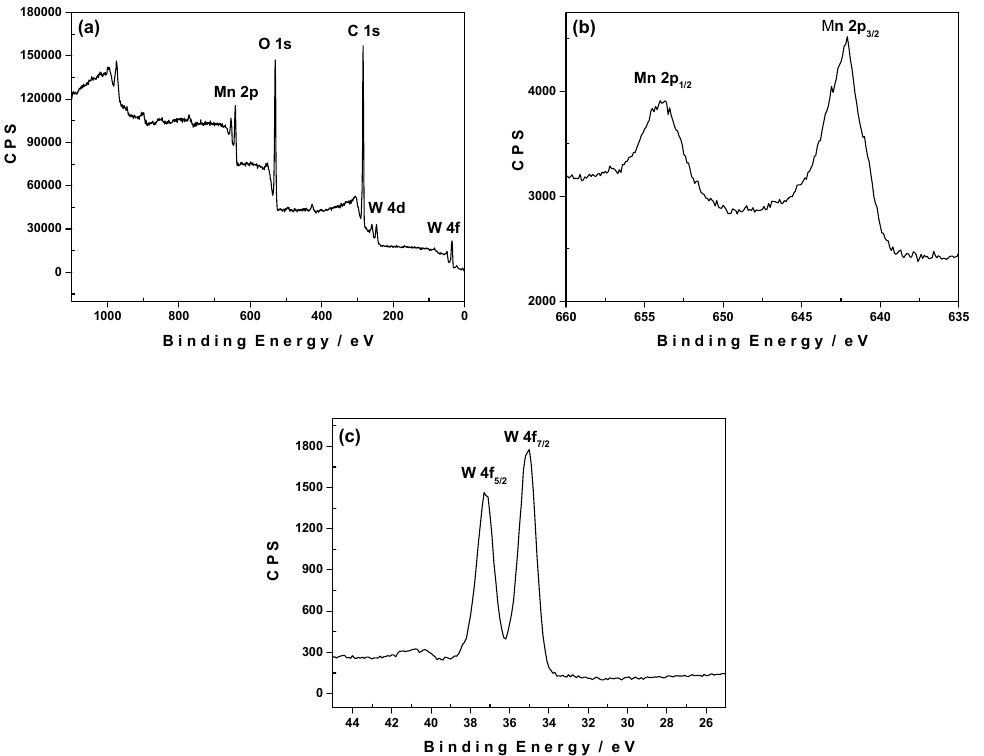
Figure 10. ( a ) XPS survey spectrum for a 1 -modified glassy carbon electrode by induced electrochemical deposition at +1.4 V vs. SCE in 1.0 M CH 3 COOLi + CH 3 COOH/pH 6. The POM concentration in the Figure 10. solution was 0.5 mM; ( b ) Mn 2p core level spectrum; ( c ) W 4f core level